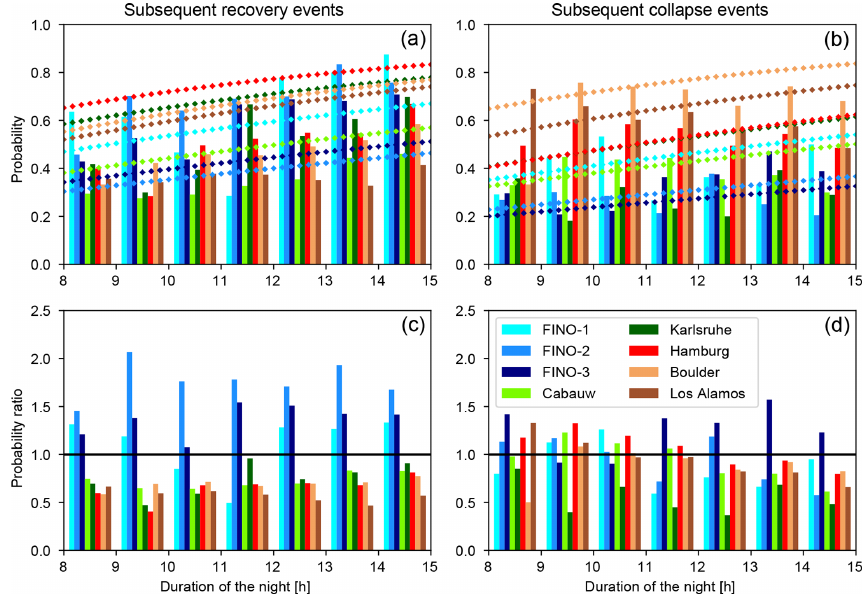
Figure 3. As in Fig. 1 but for the probabilities of the occurrence of turbulence recovery events subsequent to turbulence collapse (a, c) and turbulence collapse events subsequent to turbulence recovery events (b, d) .